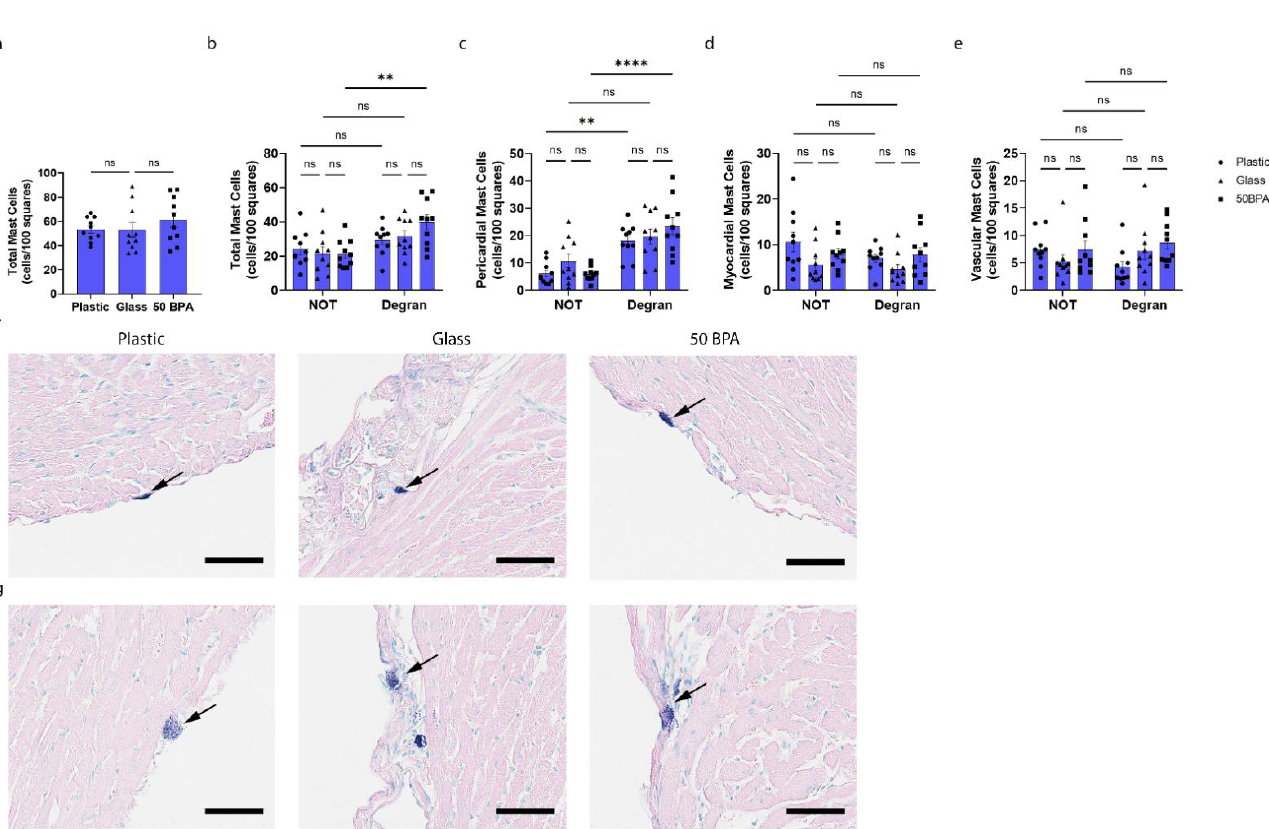
Figure 8. Plastic caging does not alter mast cell numbers or degranulation in males during myocarditis. Male BALB/c mice (blue) were given normal drinking water (drinking water that did not contain BPA) for 2 weeks and housed either in glass cages/water bottles (glass) or plastic cages/water bottles (plastic) with soy-free food and bedding. BALB/c mice housed in glass cages/water bottles with soy-free food and bedding were given either normal drinking water (drinking water that did not contain BPA) (0 BPA/glass) or 250 μ g BPA/L water (50 BPA) for 2 weeks. Mice were injected i.p. with 10 3 PFU of CVB3 on day 0 and harvested at day 10 pi. Mast cell scoring was completed using the 40× high-power objective on a compound microscope. ( a – e ) Mast cells were counted and categorized according to whether they were degranulated (small blue granules can be observed released from the cell at high power) or not and by their location as pericardial, myocardial or near vessels. Data shown as scatter plot and mean +/−SEM using one-way ANOVA with Holm –Šídák’s multiple comparisons test with 10 mice/group (** p < 0.01), (**** p < 0.0001). ( f , g ) Representative histology images of mast cells (purple, arrow). Representative images in plastic caging (plastic), glass caging (glass) or with 50 BPA in drinking water in glass cages (50 BPA) show ( f ) mast cells that are not degranulating (NOT) versus ( g ) degranulating mast cells (degran) with identifiable mast cell granules outside of the cell (magnification 400×, scale bar 60 μ m).